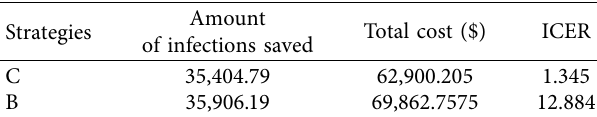
Table 8: Amount of the total infection averted and total cost used with